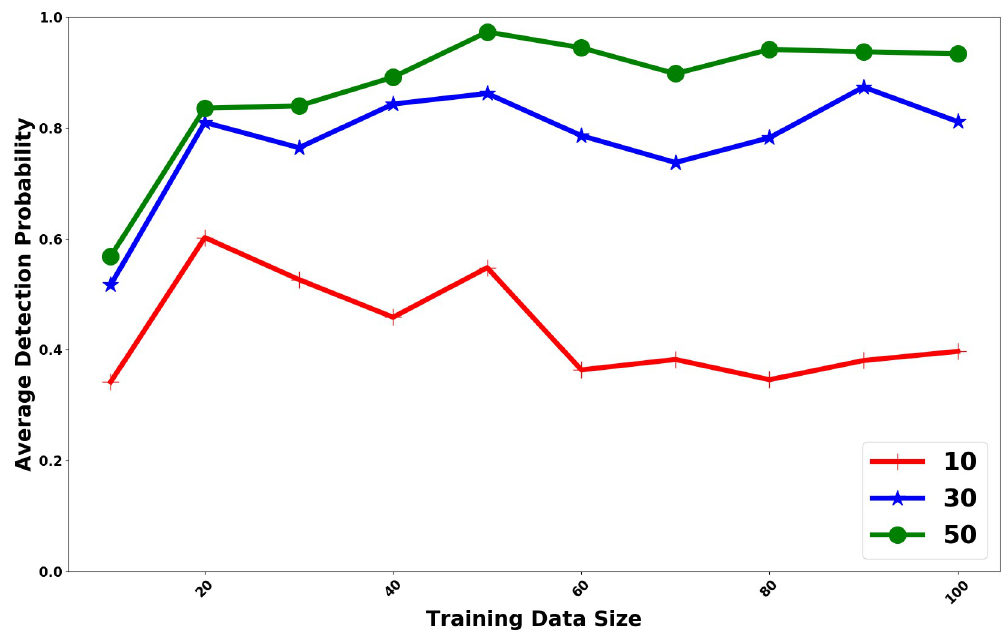
Fig 8. Average probability of detecting future outbreaks for sensor sets computed using T simulations (training), and evaluated using the remaining simulations for different budget values.